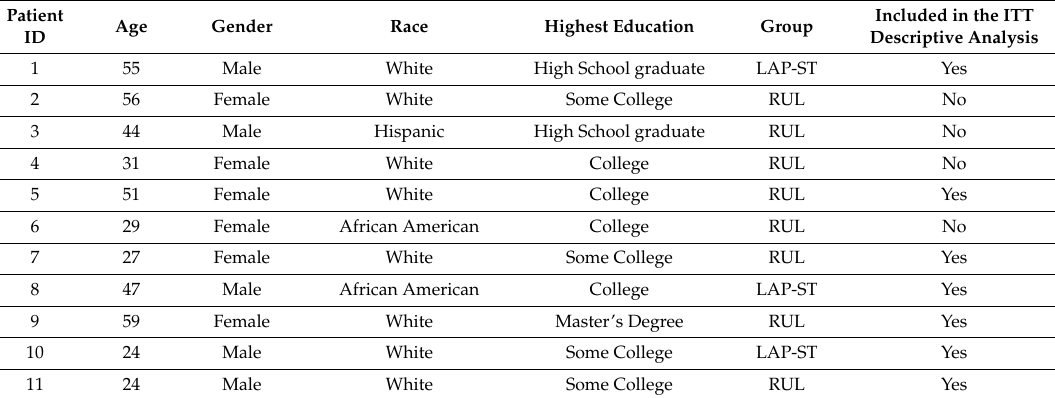
Figure 1. CONSORT Diagram: Flow diagram of the progress through the phases of the of two parallel groups randomized trial. Table 1. Demographic characteristics of